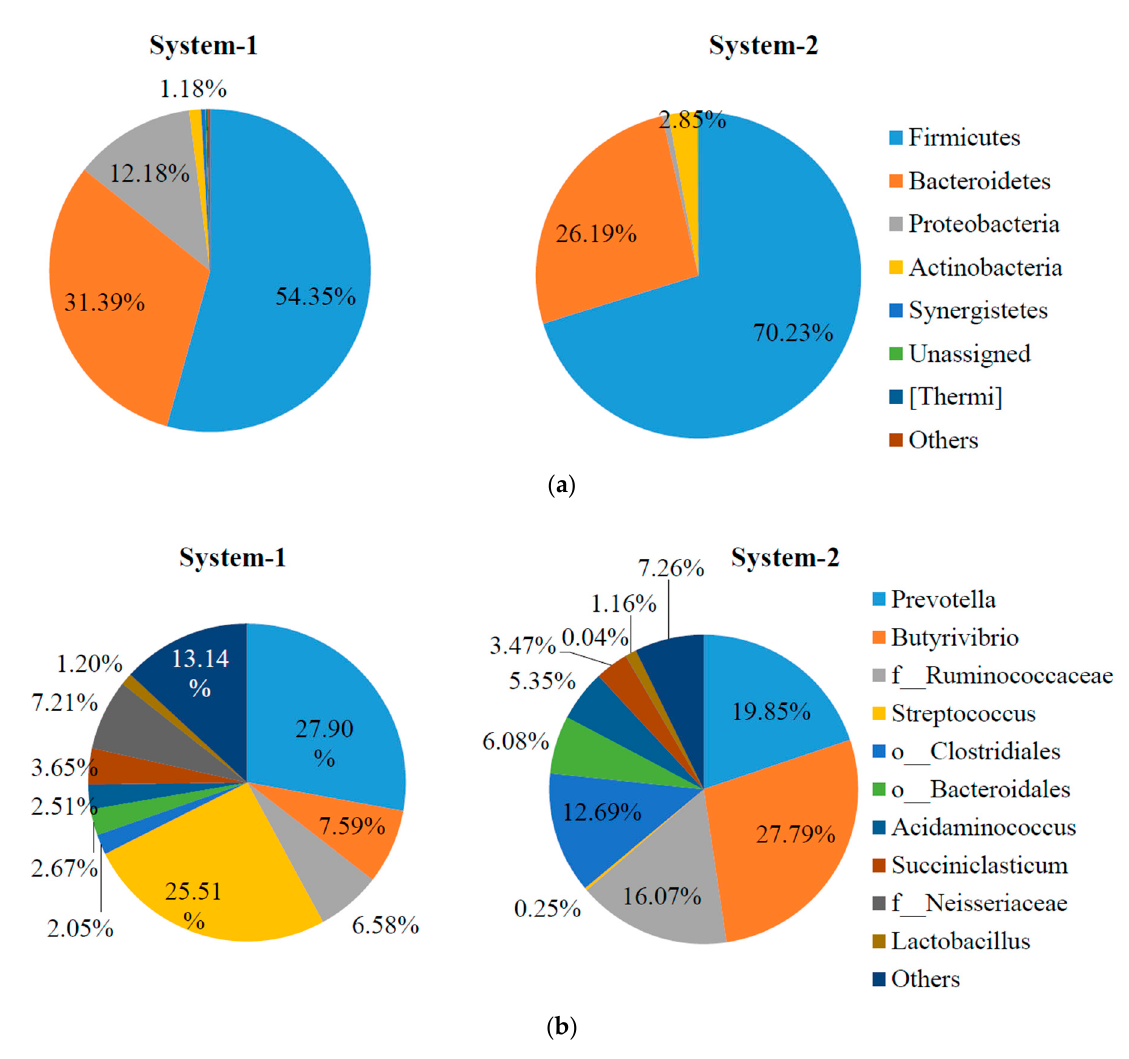
Figure 4. Relative abundance of bacterial composition at ( a ) phylum level and ( b ) genus level in fermentation process in system-1 and system-2. Note: those genera accounted for <1% of the total bacterial population were grouped into “others”. Those unidentified genera were represented by the lowest taxonomic level assigned, such as family (f_) or order (o_) level.